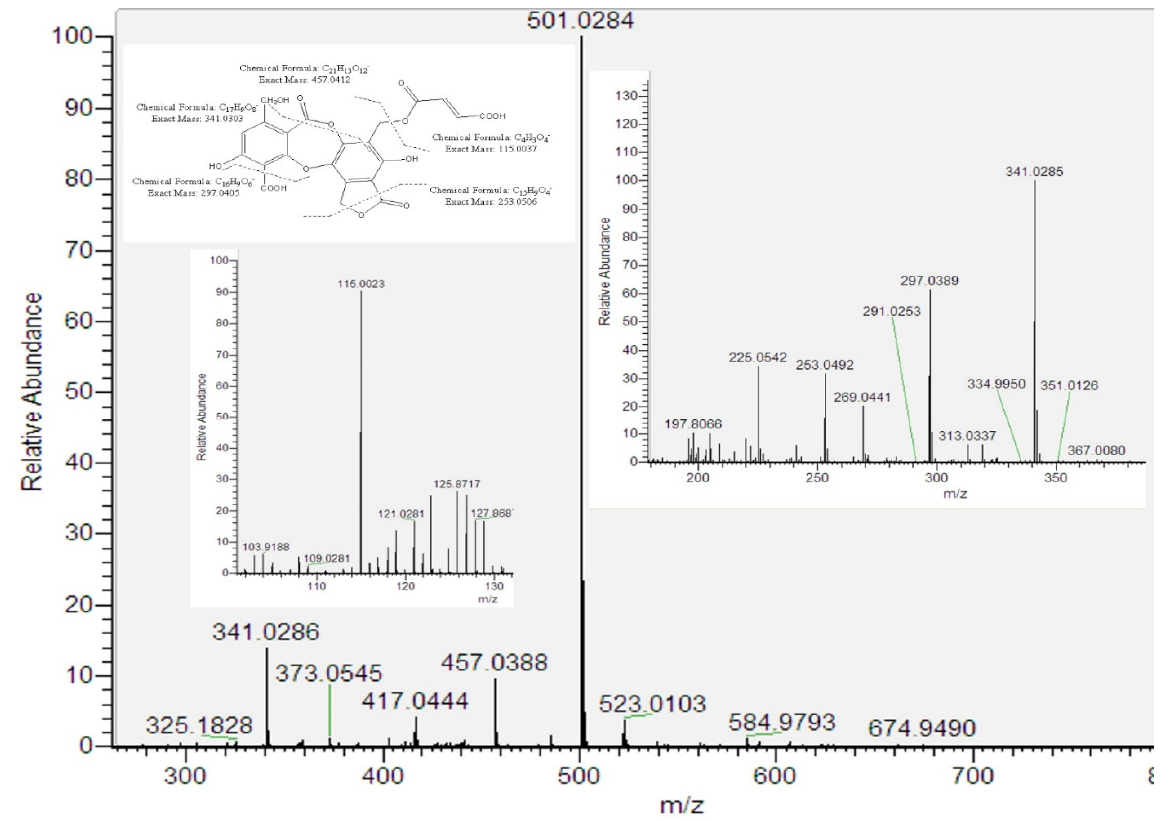
Figure 2. ESI/MS/MS spectra of peak 5 and its proposed fragmentation pathway.